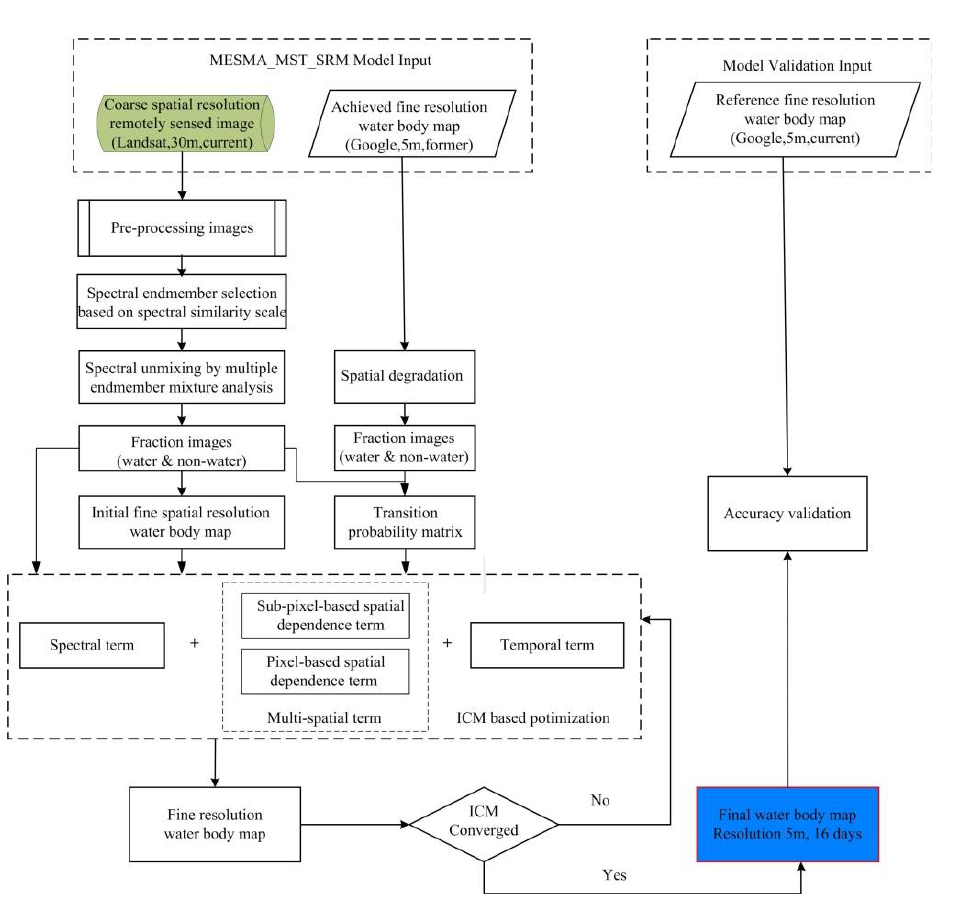
Figure 2. Flowchart of the MESMA_MST_SRM method.